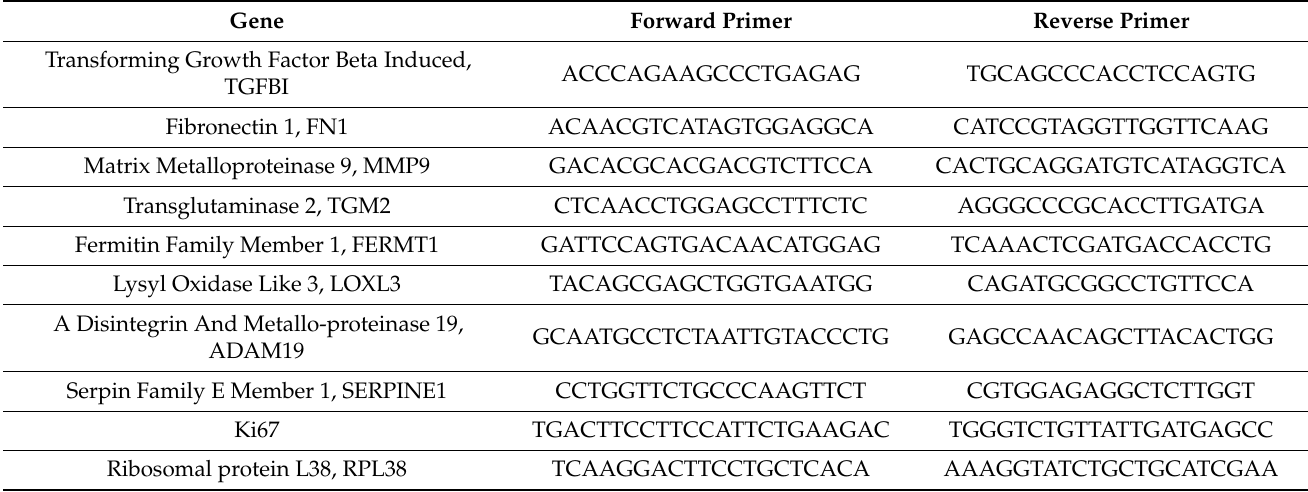
Table 1. Primer sequences used for gene expression analyses of the indicated ECM-related factors by real-time PCR. Gene Forward Primer Reverse Primer Transforming Growth Factor Beta